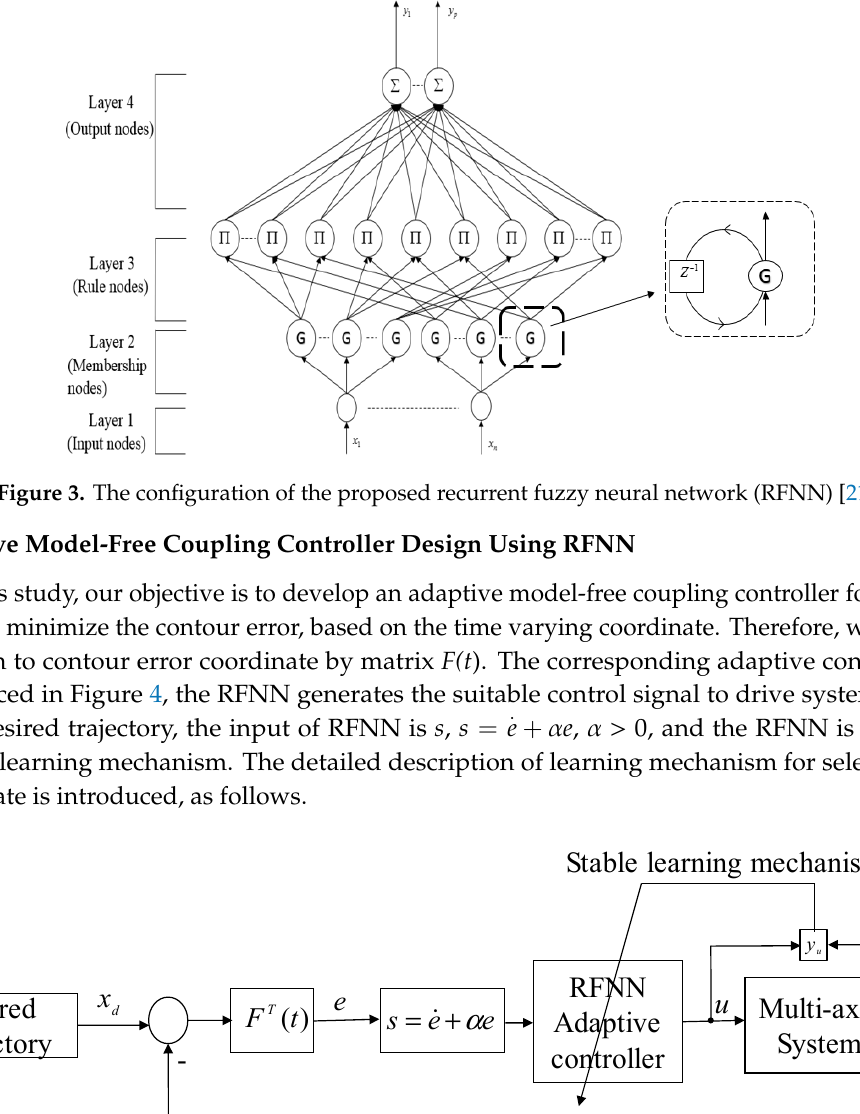
Figure 4. The proposed adaptive model-free coupling control scheme.